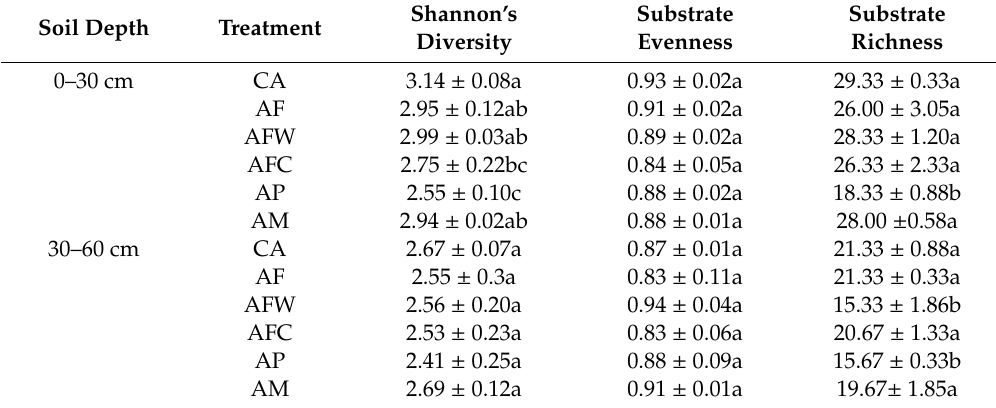
Table 2. Diversity indices of soil microbial communities (mean ± se) in different cropping systems after 96 h of incubation.